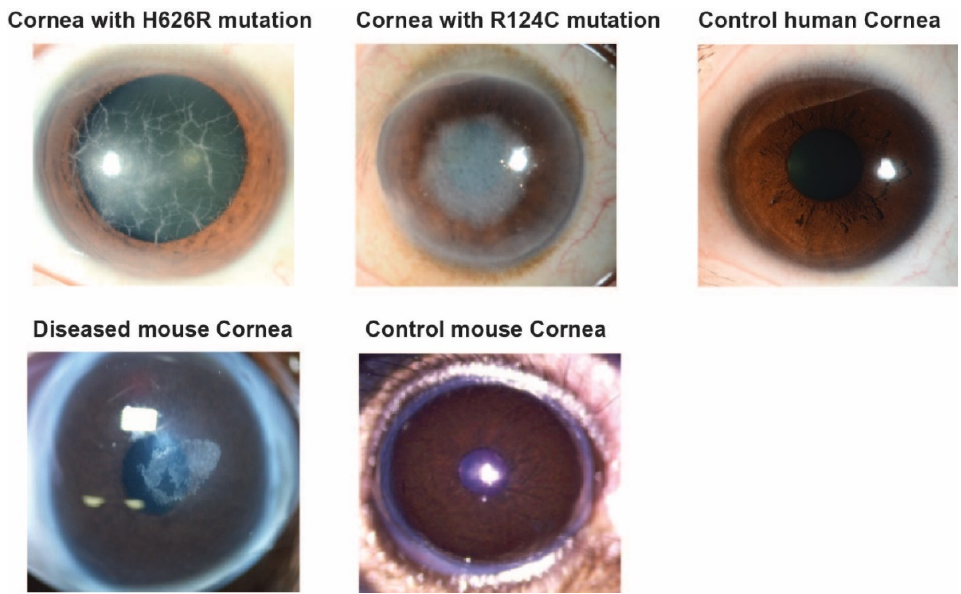
Figure 1. Corneal images showing lattice lines and aggregated proteins with opaque cornea in diseased mouse (GCD2/R124H) and dystrophic patients with H626R mutation and R124C mutation. Corneal images showing clear cornea for both the control human and control mouse samples.